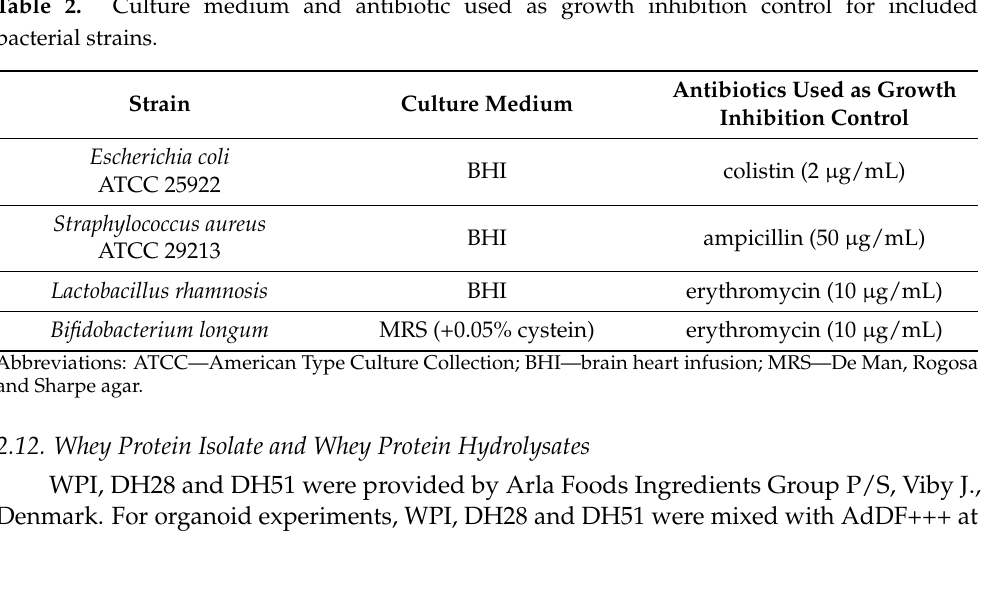
Table 1. Primer sequences.